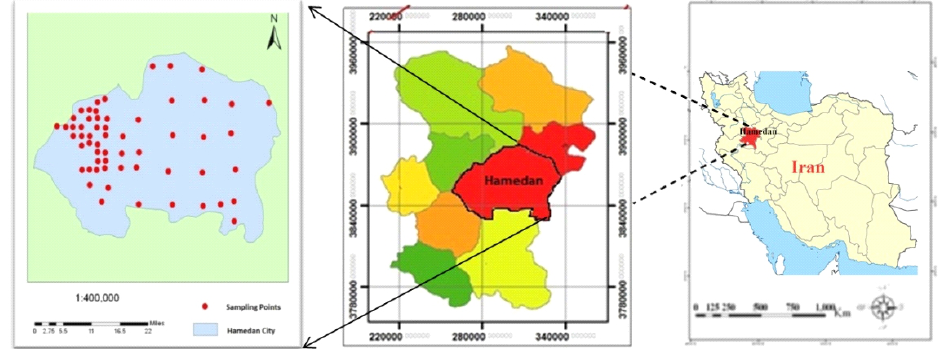
Fig. 1: Location map of the study area along with the sampling